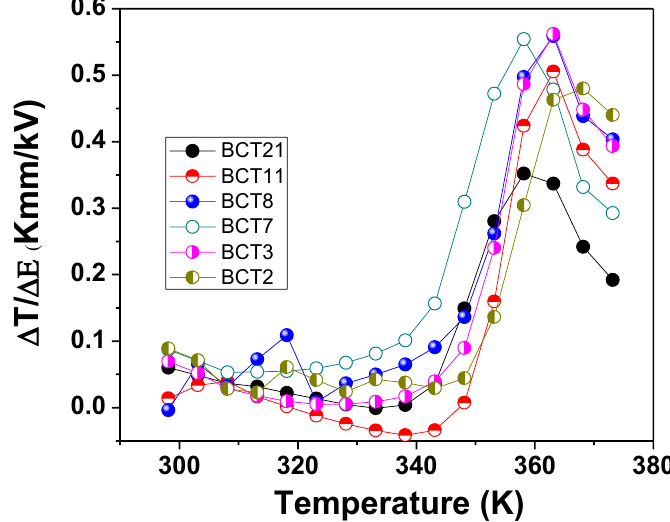
Figure 6. Electrocaloric adiabatic temperature change as a function of temperature at a few selected applied fields: ( a ) BCT21, ( b ) BCT11, ( c ) BCT8, ( d ) BCT7, ( e ) BCT3, and ( f ) BCT2.